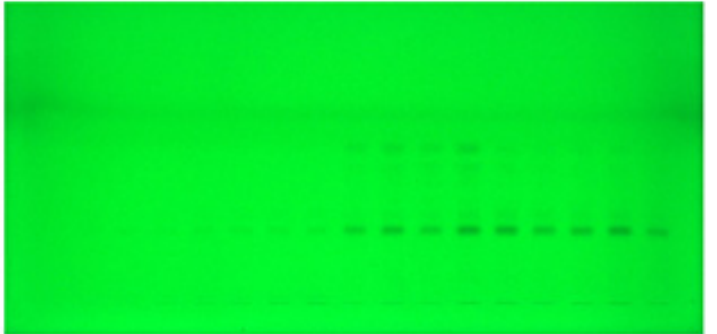
Figure 1. Pictorial diagram for thin-layer chromatography (TLC) plates of piperine (PPN) using sustainable normal-phase high-performance thin-layer chromatography (HPTLC).